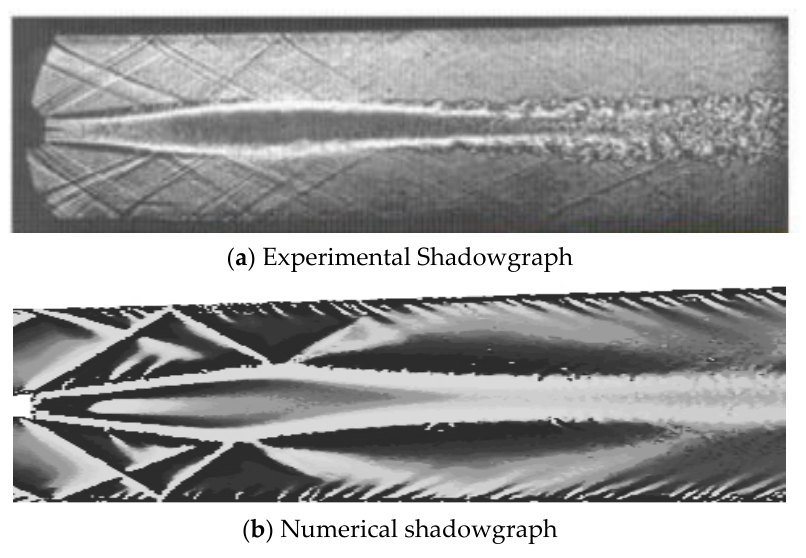
Figure 3. Comparison of ( a ) experimental results with ( b ) numerical simulation.